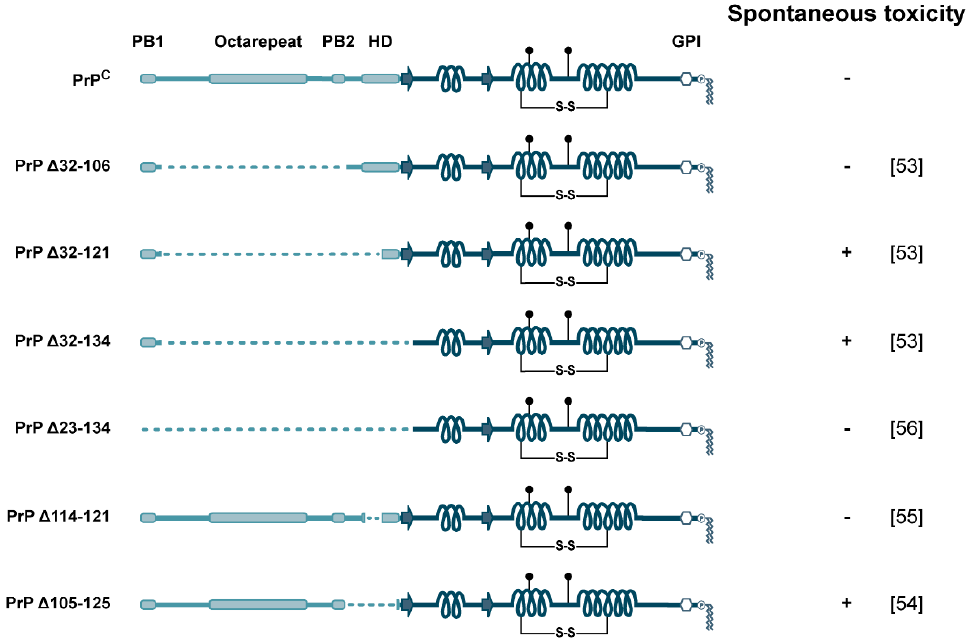
Figure 3. Neurotoxic activity of PrP C variants with N-terminal deletions. Schematic representation of PrP C variants and their spontaneous activity to induce neuronal dysfunction in transgenic mice. Respective publications are in brackets.